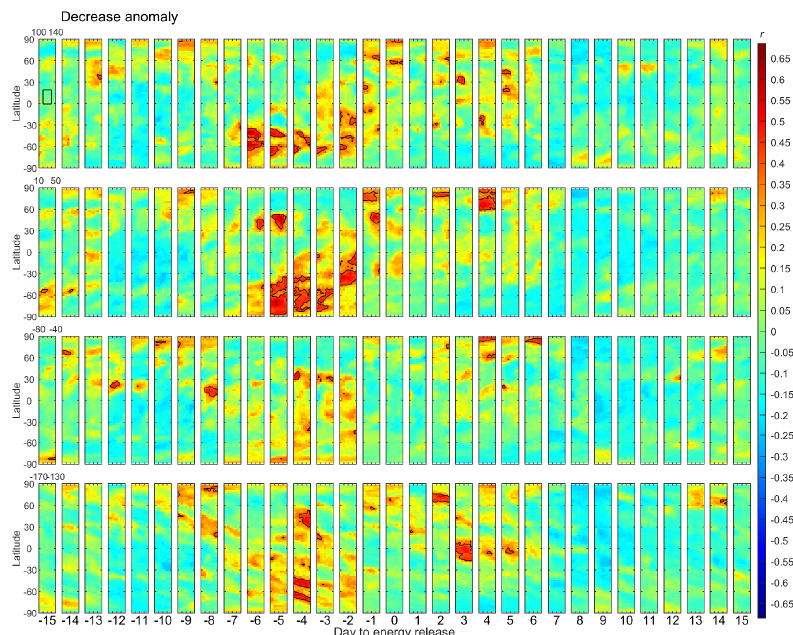
Figure 8. Temporal and spatial distributions of correlation coefficient between the daily seismic wave energy release ≥ M 5.5 with the outliers within Region B and the occurrence times of the TEC decrease anomalies. Panels from left to right represent –15 to 15 days from the seismic wave energy release (D). Top to bottom panels display the four selected longitude sectors centered over 120, 30, –60, and –150°E, respectively, each with a width of ±20°. The contour denotes r α = 0 . 01 according to sample size at each D. The black box on the top first panel indicates Region B.